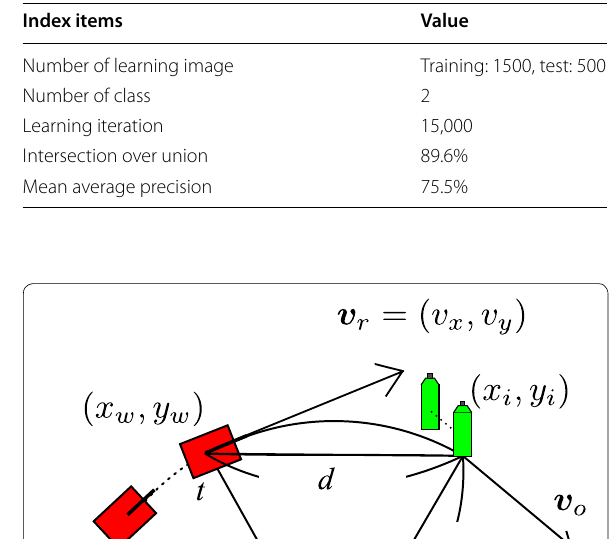
Table 2 Working object detection performance